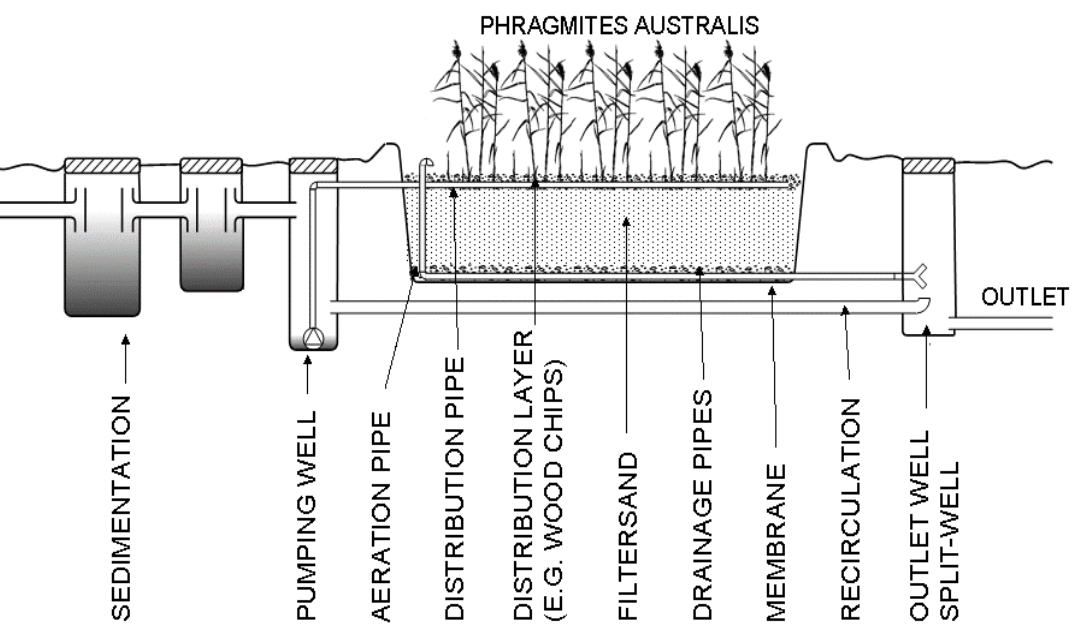
Figure 8. Layout of a vertical flow constructed wetland system for a single